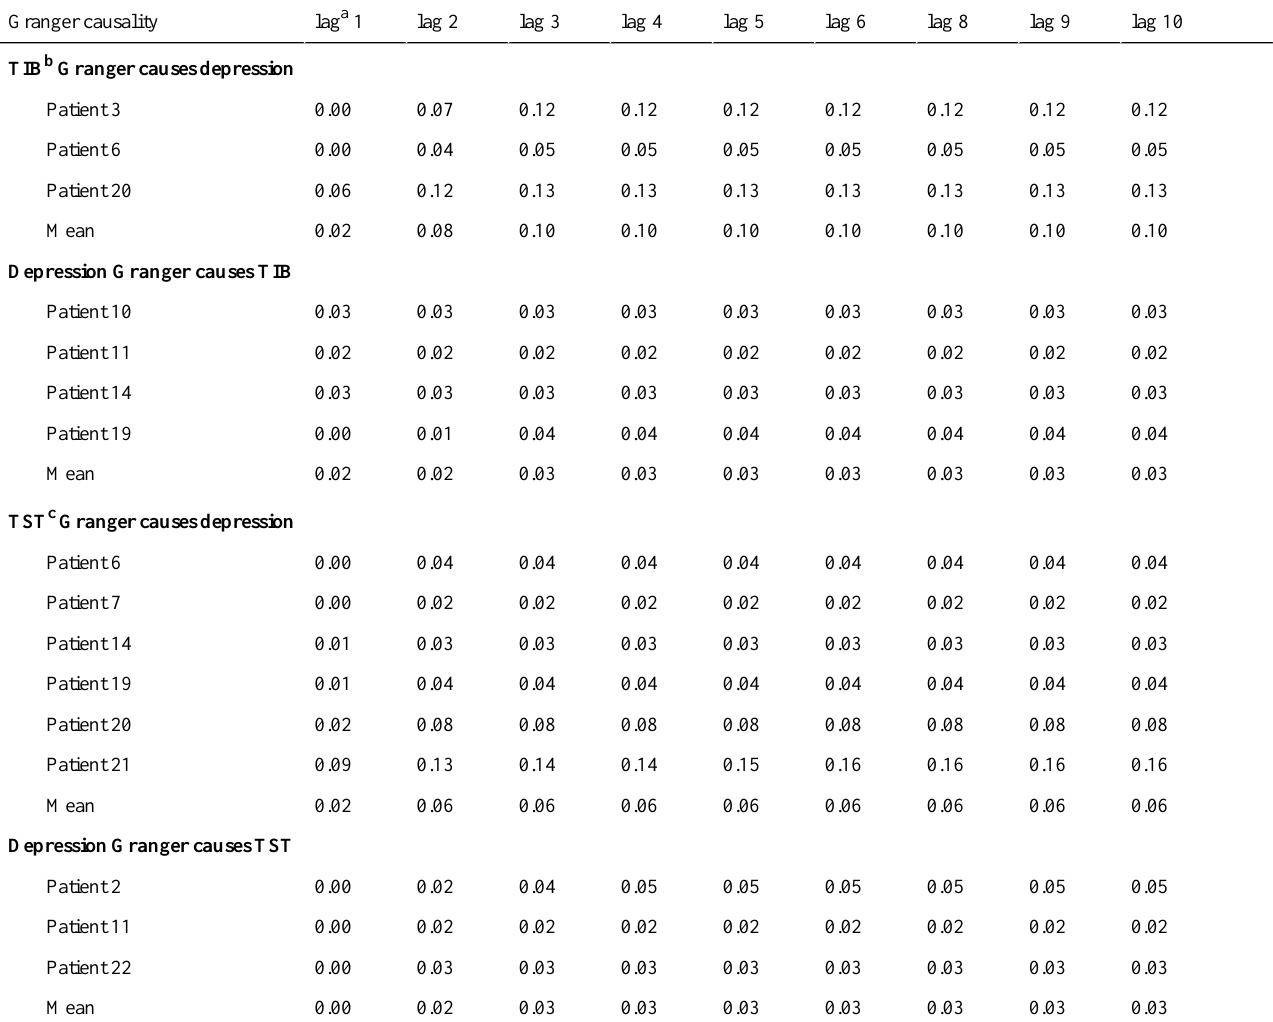
Table 4. Explained variance in depression core symptoms and time in bed at different time lags for all patients with significant Granger causality test